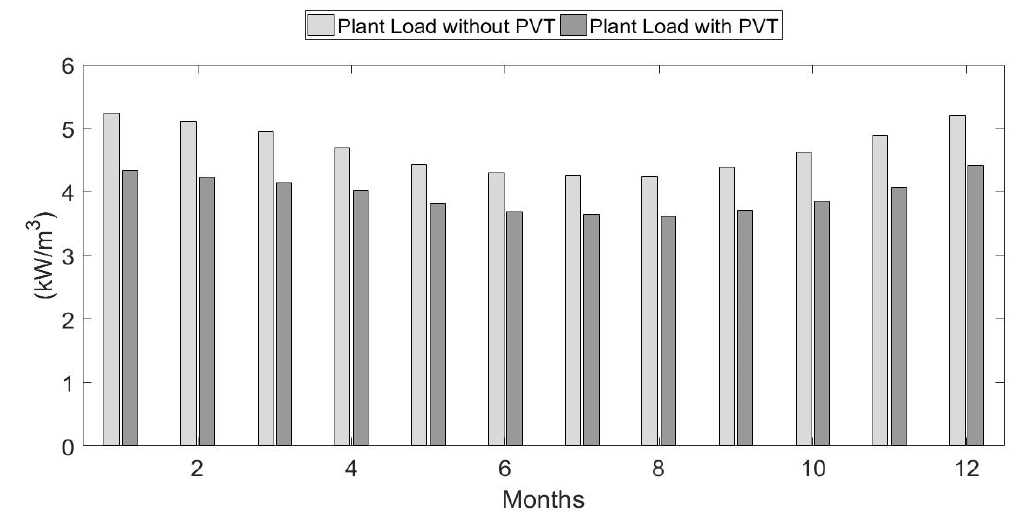
Figure 12. Monthly plant energy loads with and without PVT.